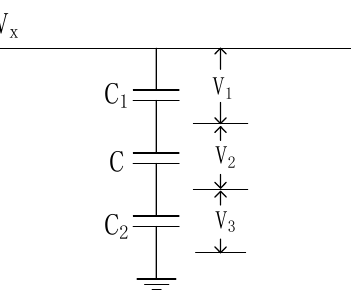
Figure 1. Three-Capacitor Voltage Dividing Equivalent Circuit. Assume that the sensor is a coaxial cylindrical structure with the transmission line as the axis. In the figure C 1 is the primary capacitance produced by the coupling of the inner pole plate of the sensor with the transmission line, C is the sensor capacitance, and C 2 is the secondary capacitance between the outer pole plate and the ground of the sensor. Based